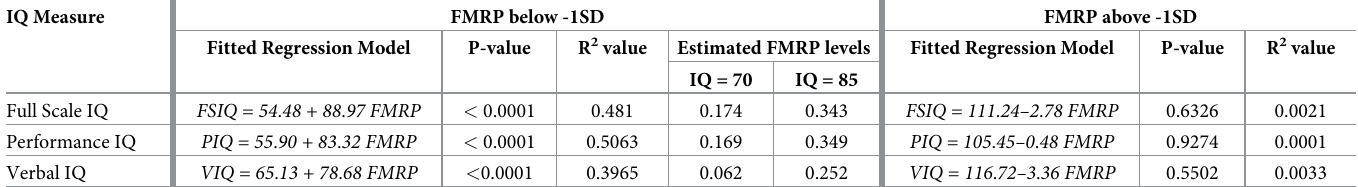
Table 2. Piecewise regression models assessing the relationships between X = FMRP level (normalized to normal controls) and Y = IQ, and estimated FMRP levels corresponding to IQ = 85 and 70. IQ Measure FMRP below -1SD FMRP above